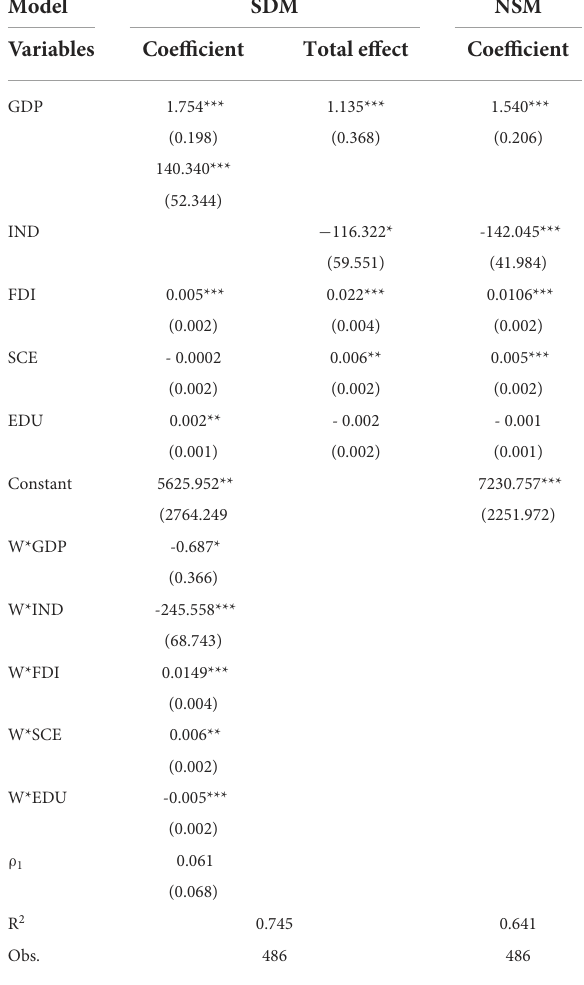
TABLE 4 Regression model results of influencing factors of SI